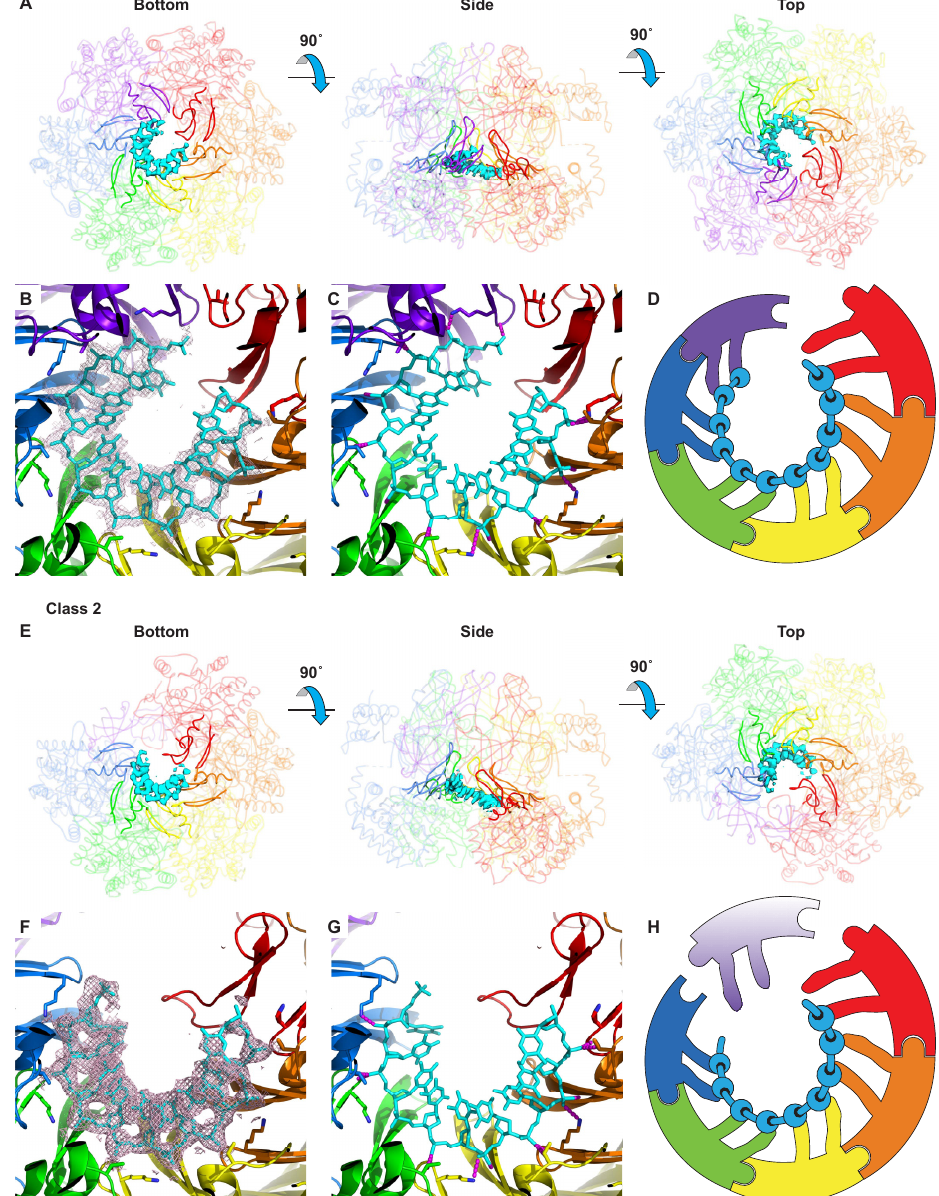
Figure 3. DNA binding in the two structural classes of MCM–ssDNA–MgADP-BeF 3 . The illustrated maps and models were obtained by refinement of the merged particles of the respective classes obtained for three different oligonucleotides (see Figures S6–S8). ( A ) Three orthogonal views of class 1 with the ssDNA portion of the map depicted in cyan and the protein model in ribbon representation. The two DNA-binding hairpins of each subunit are shown in opaque, and the other protein features are partially transparent. The panel view is identical to Figure 1A,B. ( B ) Zoom-in view of the class 1 model illustrating the DNA-binding hairpins and ssDNA. All 4.0-sigma density within 2.5 Å of the modeled DNA shown in mesh. Eleven nucleotides of ssDNA are observed for class 1. ( C ) An identical view to ( B ) illustrating all MCM–DNA hydrogen bonding interactions (<3.5 Å) in dashed magenta with density mesh removed for clarity. ( D ) Cartoon summarizing the sequential interactions of MCM DNA-binding hairpins with the 11 DNA nucleotides, each represented by a bead on a string. ( E ) Three orthogonal views of class 2 with the ssDNA portion of the map depicted